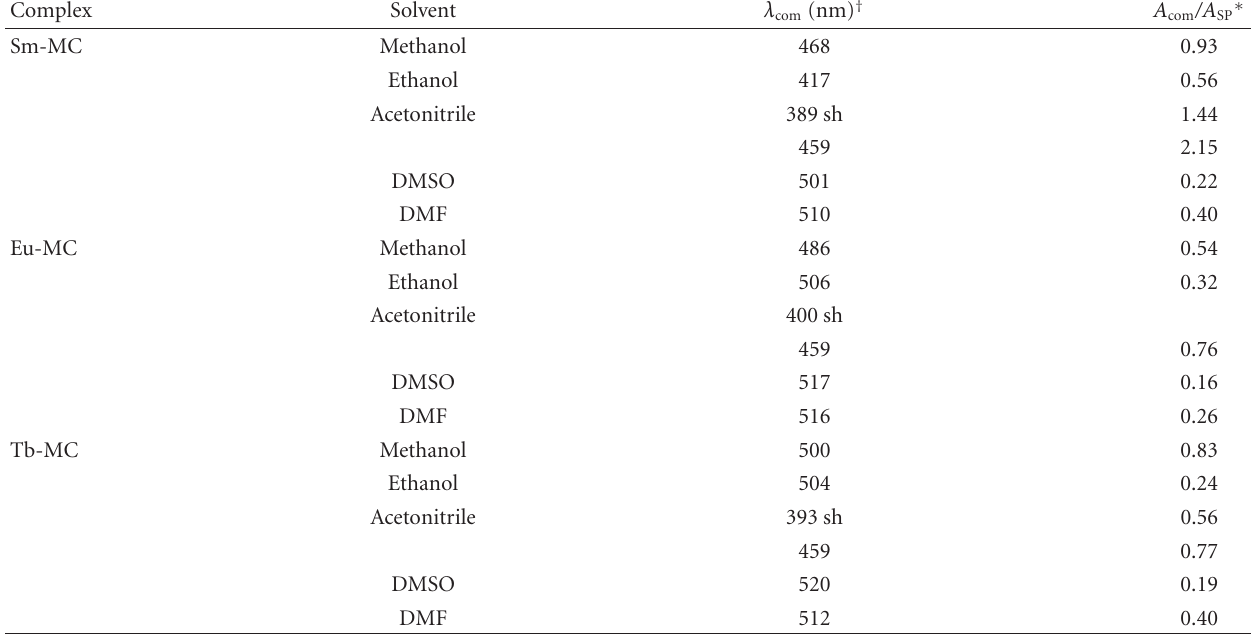
Table 2: Absorption maximum of the MC-M n+ complex and the ratio of absorbances of SP form and the complex in di ff erent solvents. Complex Solvent λ com (nm) † Sm-MC Methanol